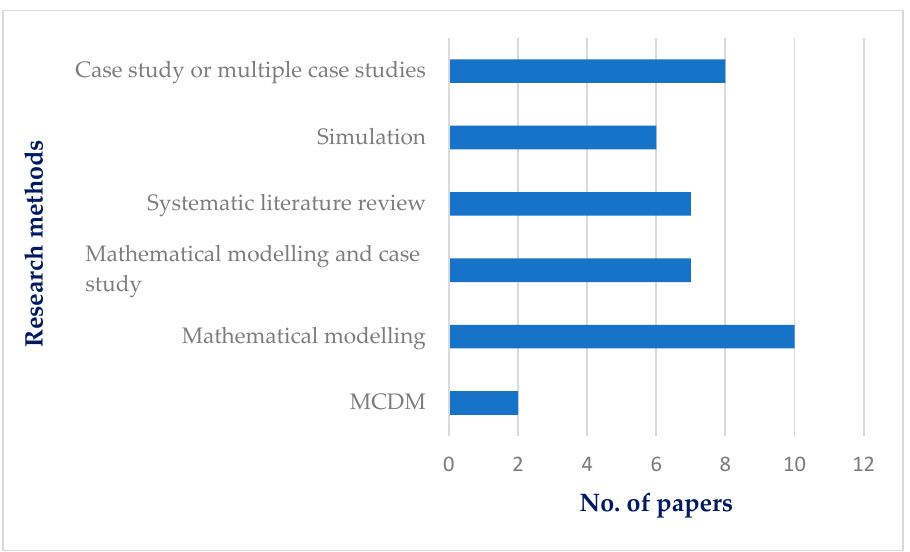
Figure 8. Distribution of papers by dominant research methods.